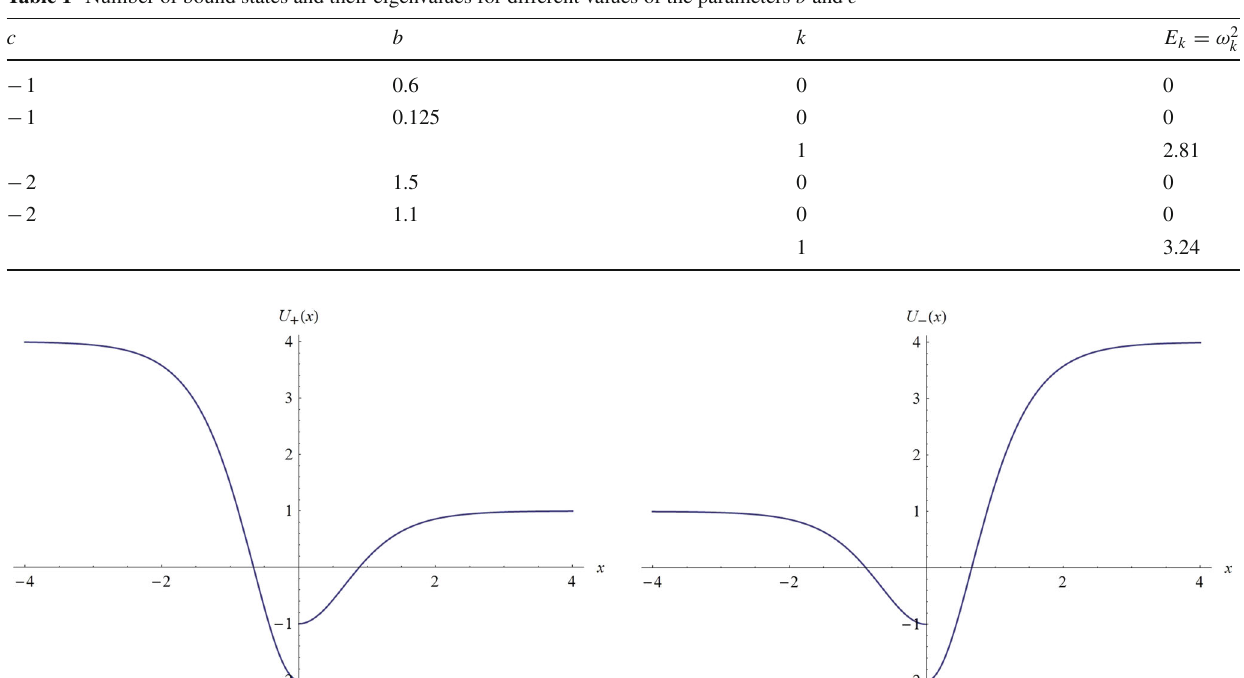
line), and b = 0 . 125 (dashed line). On the right, we have plotted the potential with c = − 2, and b = 1 . 5 (solid line), and b = 1 . 1 (dashed line)